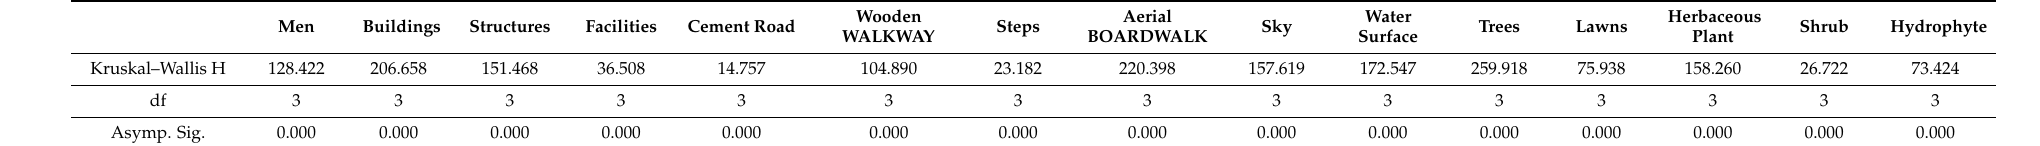
Table 4. Test statistics a,b